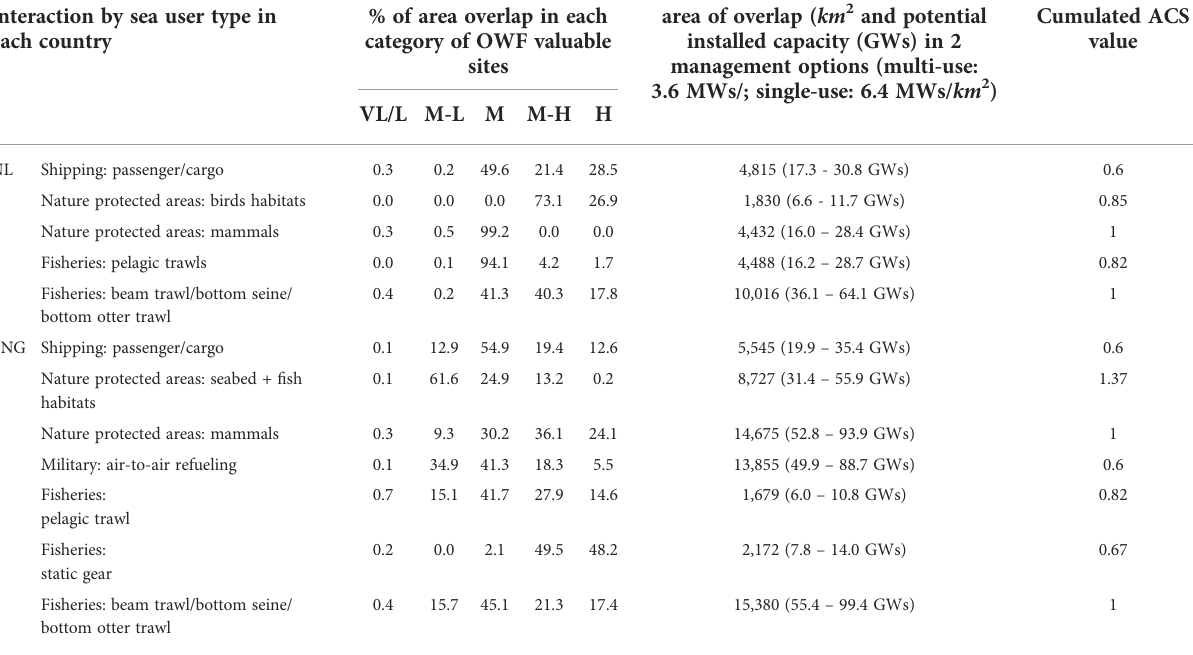
TABLE 3 Distribution of areas with low dif fi culty to unlock (low ACS and 1 or 2 overlapping interactions), with a medium or high OWF development potential (minimum 6 GWs installed capacity), within OWF valuable sites (VL-very low/L-low; ML-medium-low; M-medium; MH- medium high;